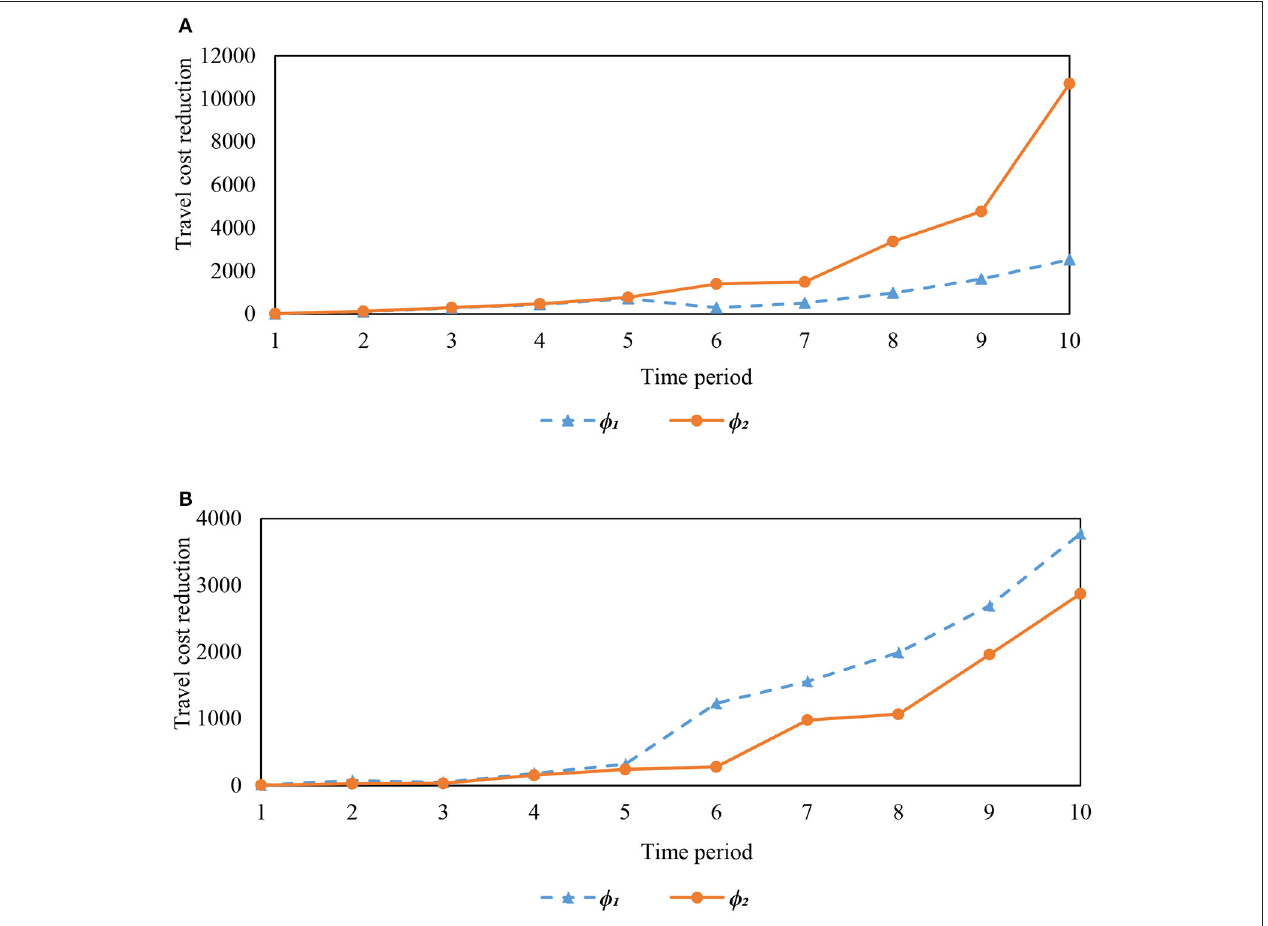
FIGURE 5 | Average travel cost reduction for HDVs and AVs for different equity thresholds. (A) HDV. (B)